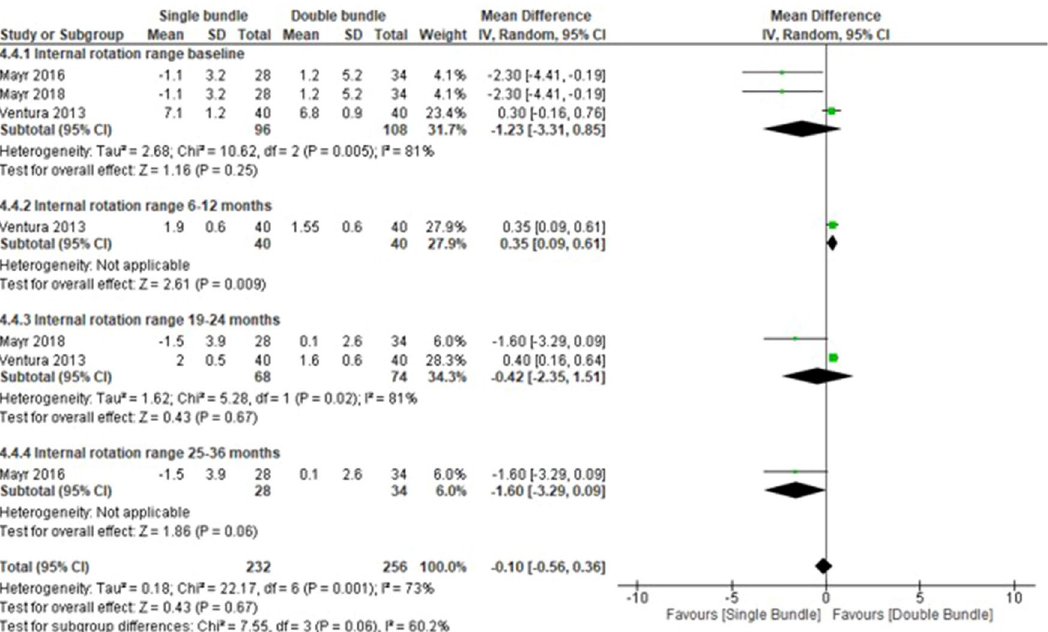
Figure 5. Rotational knee stability data forest plot outcomes for single-bundle versus double-bundle reconstruction. Weights are from random-effects analysis. ( A ) Dichotomous data for the pivot shift test (9 studies in the baseline period, 842 patients; 4 studies in the 6–12-month period, 242 patients; 3 studies in the 19–24-month period, 296 patients; 1 study in the 25–36-month period, 84 patients and 5 studies in the > 36-month period, 493 patients). The heterogeneity was high: τ 2 = 0.00; χ 2 = 58.24, df = 21 ( P = < 0.001); I 2 = 64% (CI, confidence interval; M-H, Mantel–Haenszel). ( B ) Continuous data for the internal rotation range